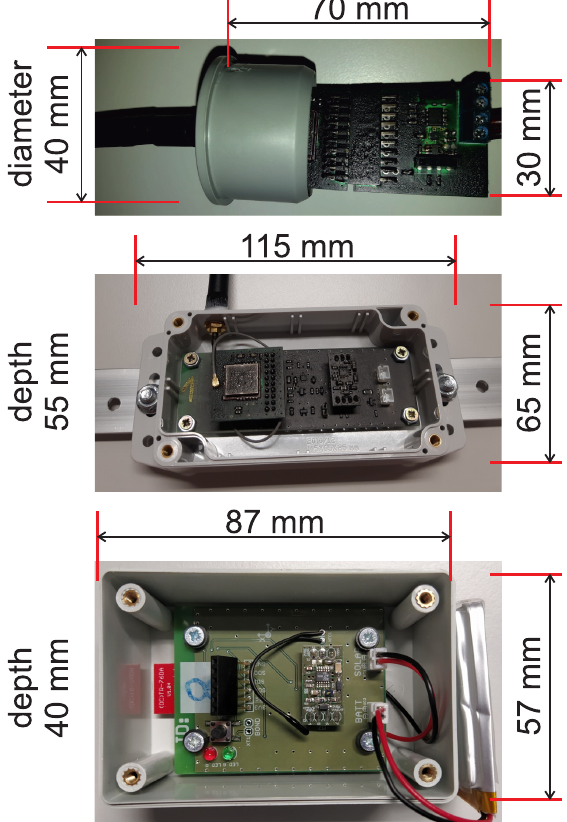
Figure 3. Accelerometer wireless sensor nodes: first generation with LIS2DS12 sensor ( top ), second generation with LIS2DW12 sensor ( center ), third generation with LIS2DW12 sensor ( bottom